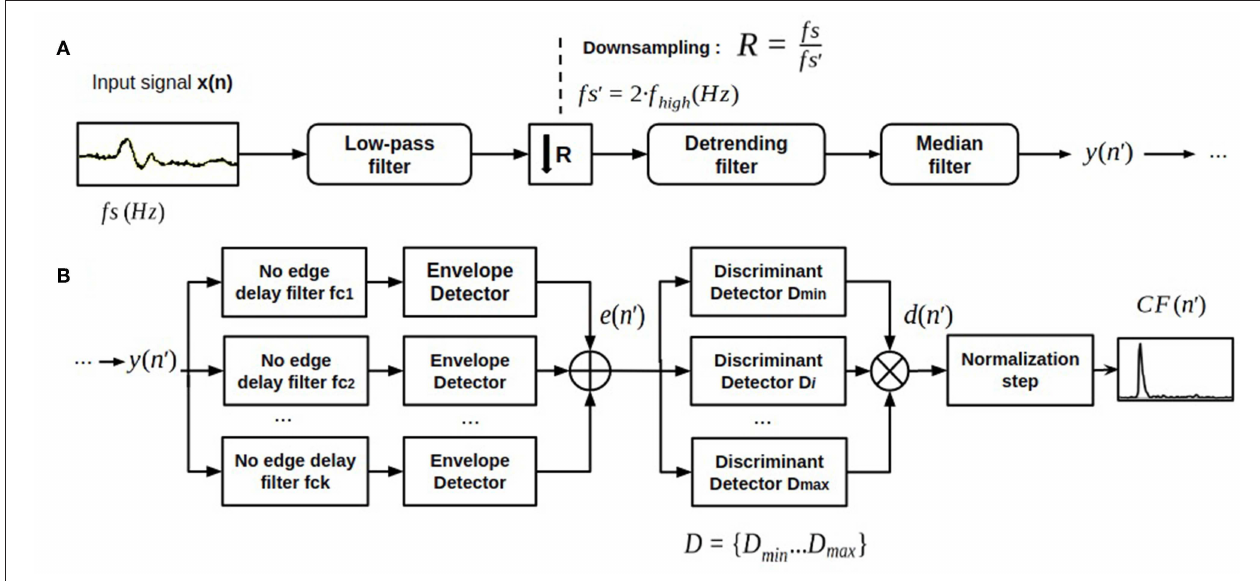
FIGURE 1 | VINEDA Algorithm block diagram. (A) The signal is decimated and filtered in order to suppress noise and avoid spike distortions. (B) Successive steps focus on the detection of infrasound explosions onset, using specialized designed filters and a discriminant detector based on a priori knowledge of the infrasonic explosions. The computed characteristic function CF contains the detected explosions.